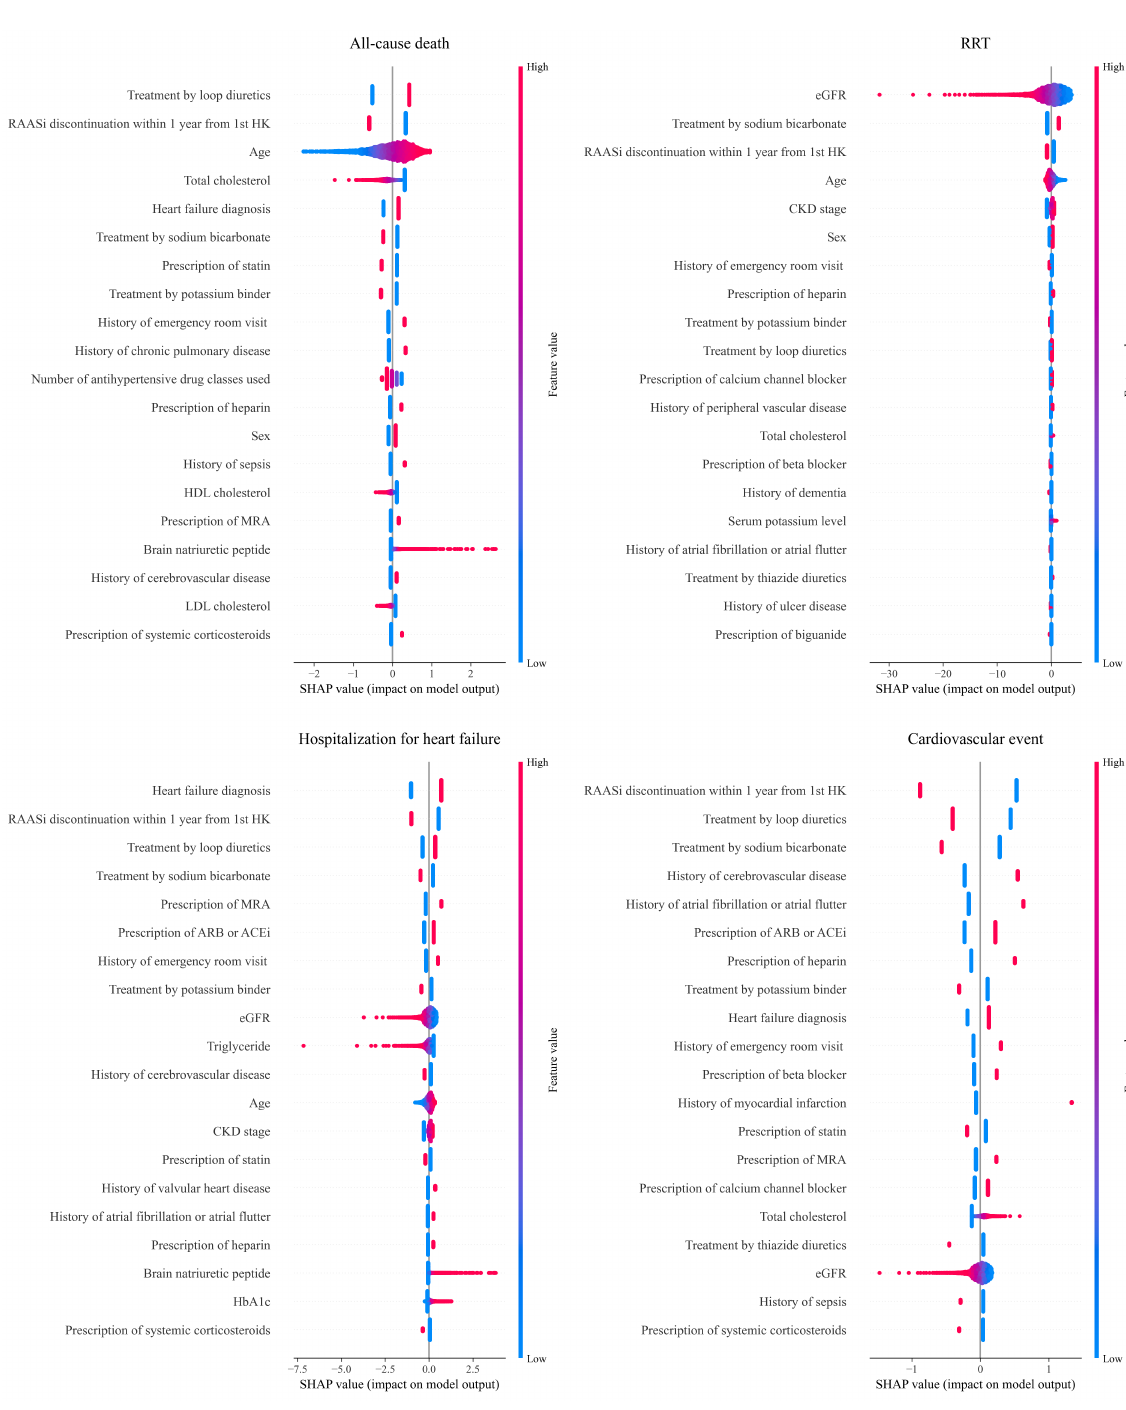
Figure 4. Shapley additive explanations summary plots of the top 20 most important variables for Figure 2. This is a figure. Schemes follow the same formatting. If there are multiple panels, they the logistic regression should be listed as: ( a ) Description of what is contained in the first panel. ( b ) Description of what is contained in the second panel. Figures should be placed in the main text near to the first time they are cited. A caption on a single line should be centered. Table 1. This is a table caption. Tables should be placed in the main text near to the first time they are cited.